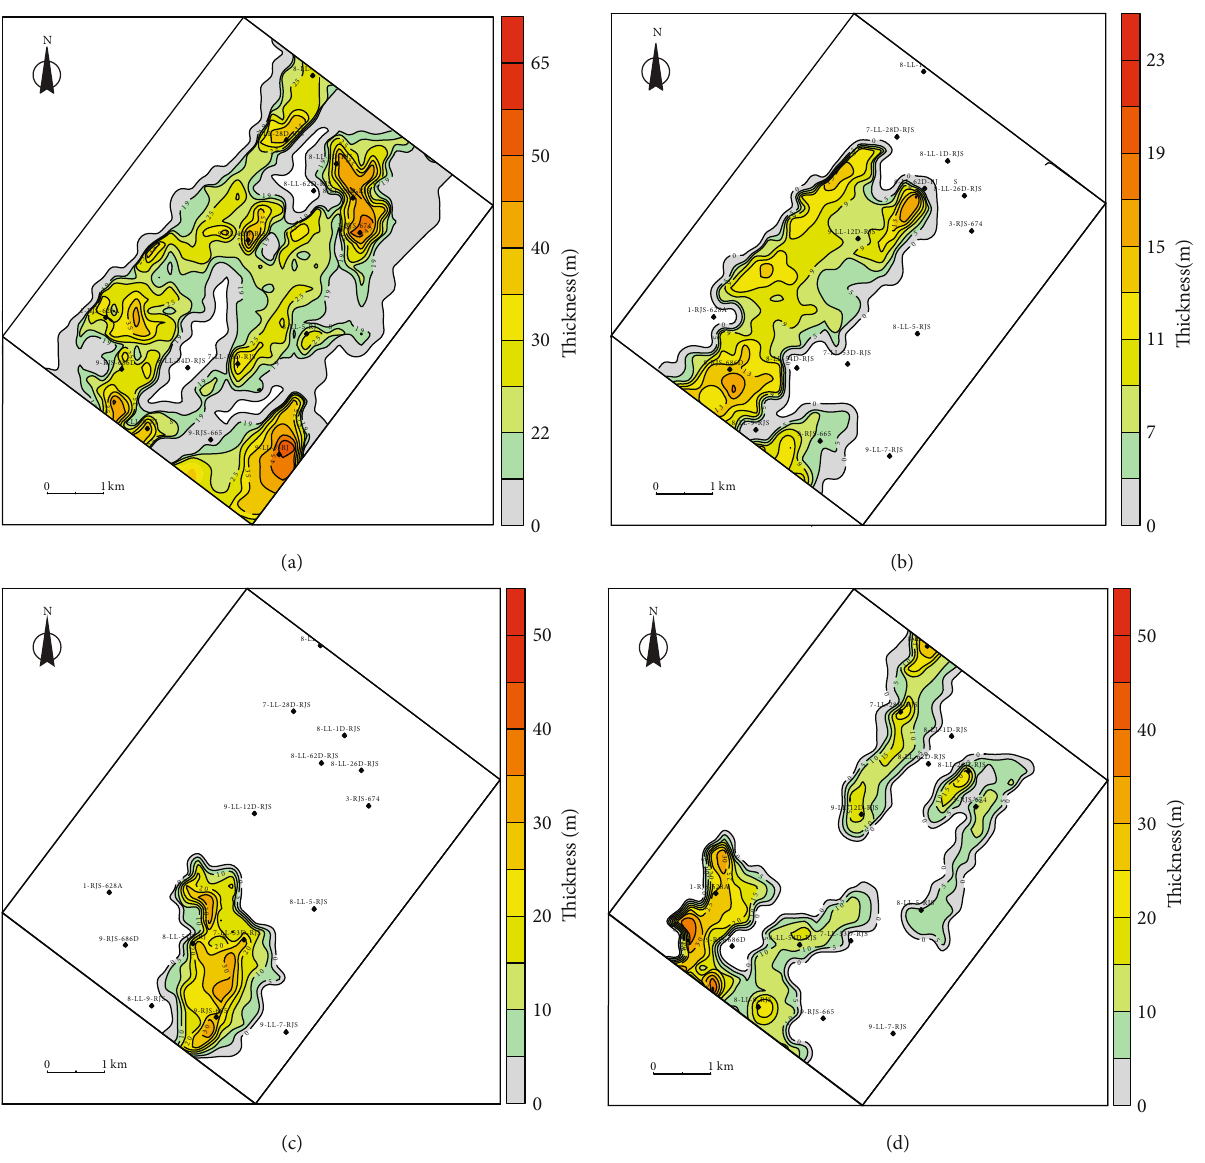
Figure 16: Favorable reservoir thickness plane distribution